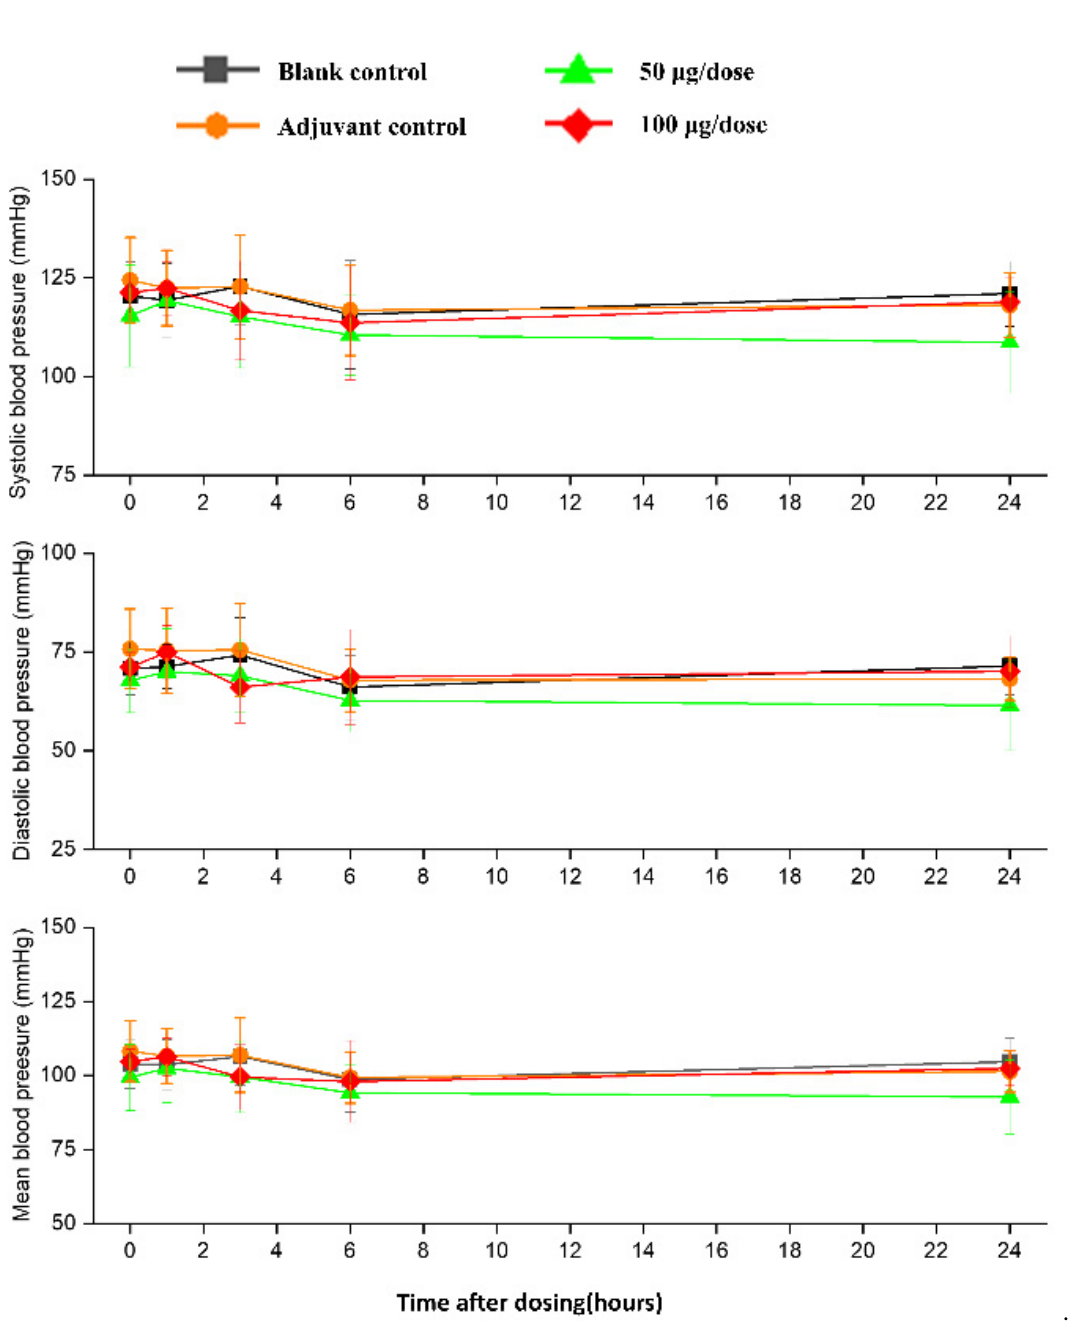
Figure 7. The effects of intramuscular injection of ZF2001 on systolic blood pressure, mean blood pressure and diastolic blood pressure in cynomolgus monkeys, n = 8 in each group. p > 0.05, vs. the blank group.